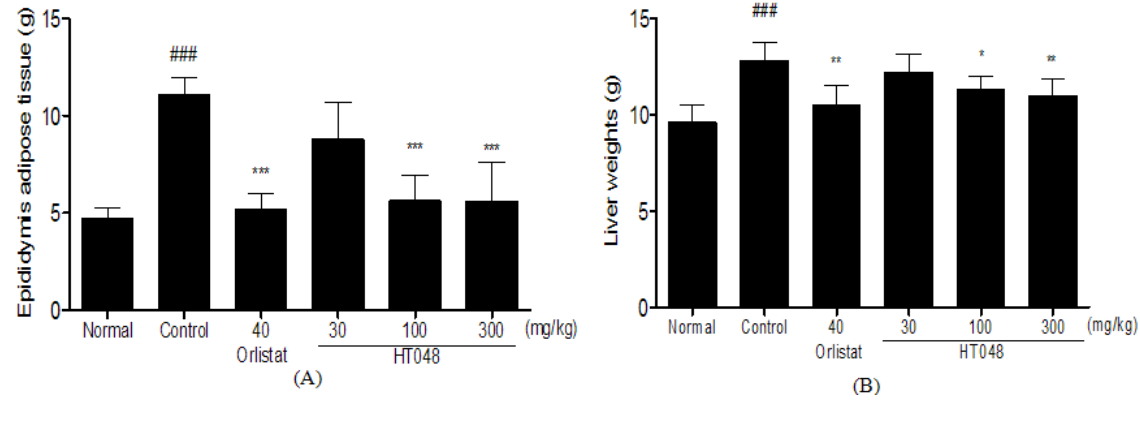
Figure 4. ( A ) Effects of HT048 on changes in epididymal adipose tissue ( B ) and